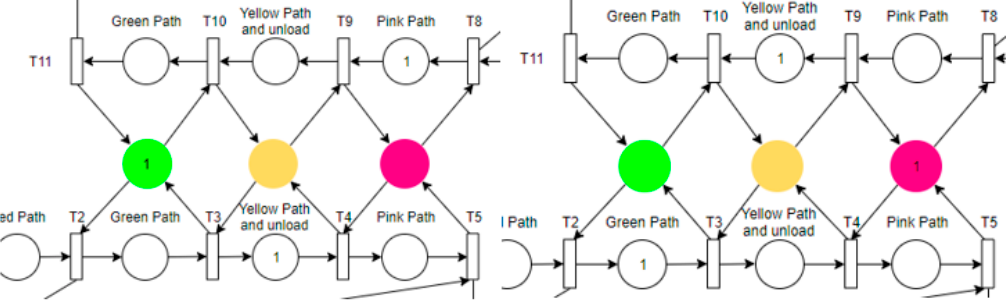
Figure 18. Case IV: deadlocks represented in Petri nets (S10 on the left, S11 on the right).